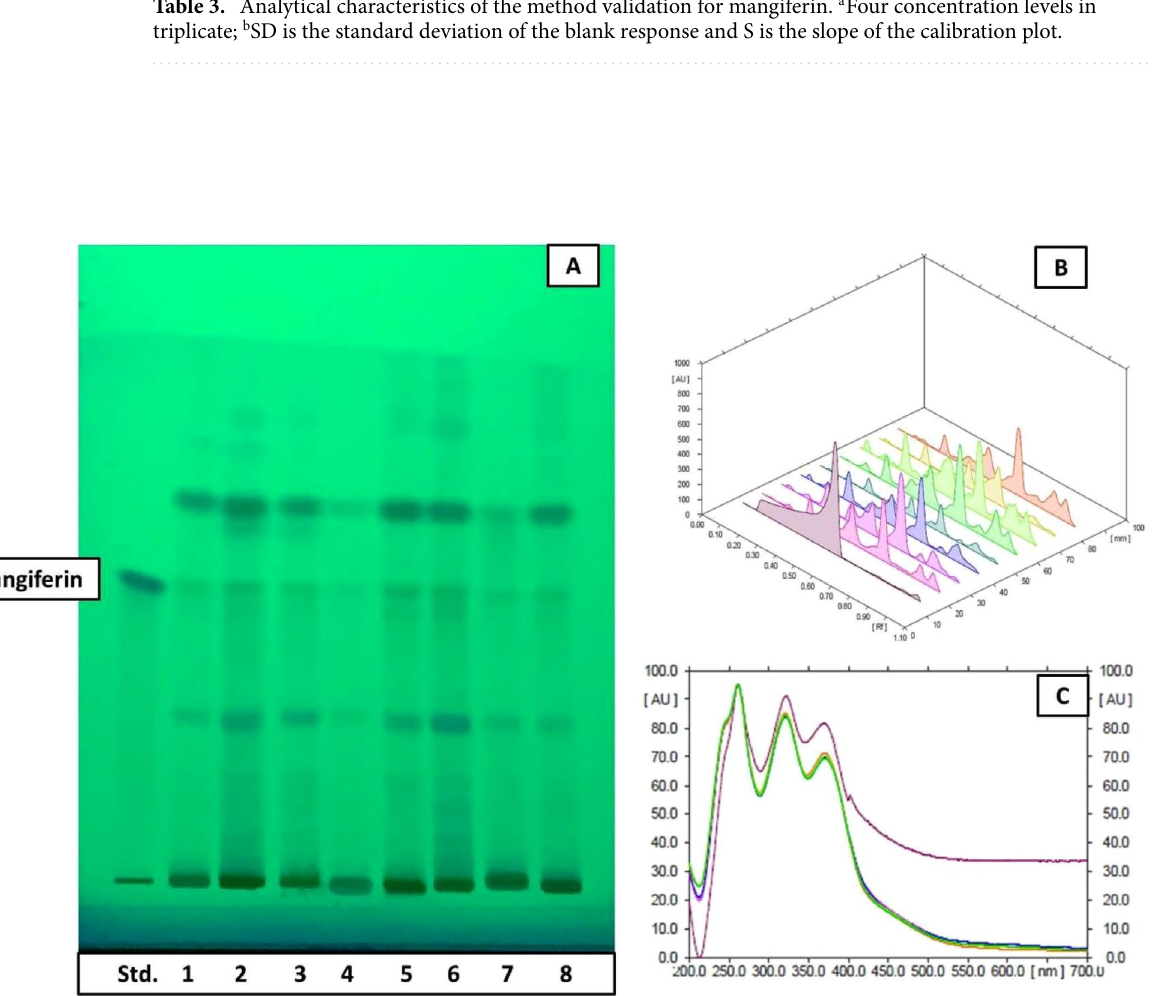
Figure 4. HPTLC fingerprinting ( A ) under UV 254 light where tracks 1–3 represent sample prepared with HRE, UAE and MAE methods (using 50% EtOH); whereas 4–8 tracks represent sample harvested at different stages (Juvenile, Vegetative, Bud stage, Flower stage and Fruit stage, respectively) matched with standard compound- mangiferin (1st spot); ( B , C ) demonstrate 3-D densitogram and overlay spectra of Swertia chirata test samples compared with standard compound